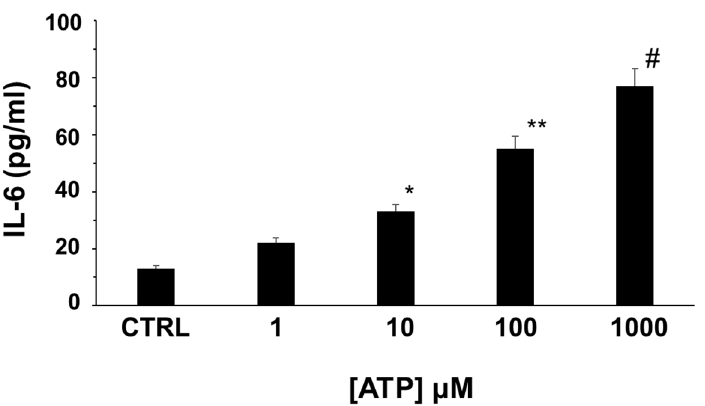
Figure 6. Effects of the stimulation of human white adipocyte with different concentrations of ATP on IL-6 secretion. * p < 0.05; ** p < 0.01; # p < 0.001.